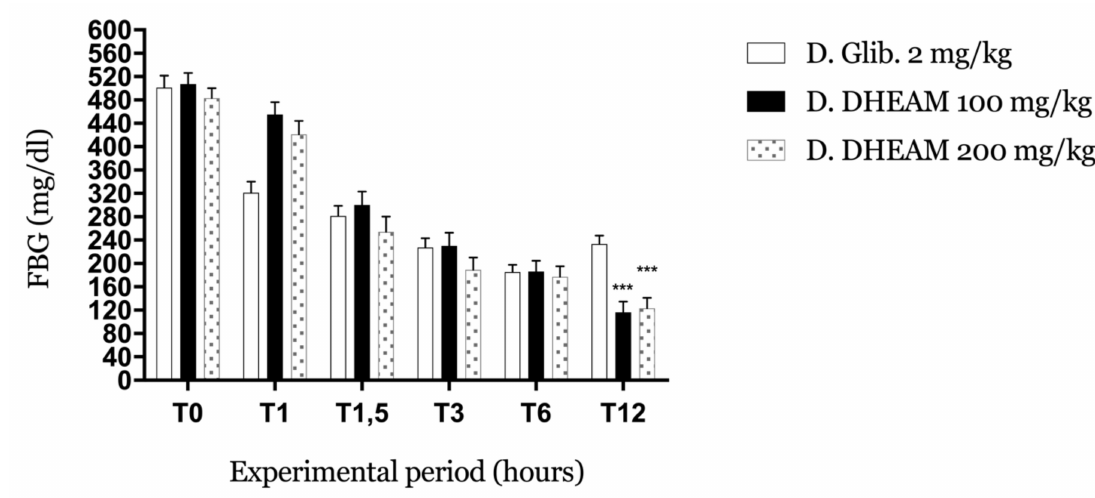
Figure 3. DHEAM e ff ect over the study duration of 12 h on the hyperglycemic state of Alloxan-induced diabetic mice. Values are expressed as mean ± SD (n = 5 mice). *** p < 0.001 compared to diabetic control.